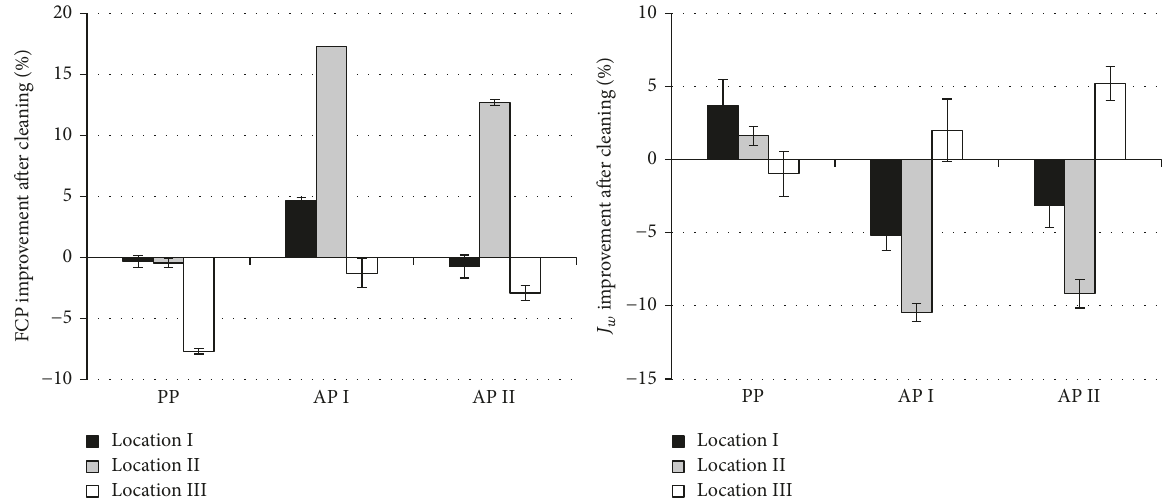
Figure 9: Normalized permeability ( 𝐾 𝑤 ) and FCP improvements after laboratory cleaning with standard plant cleaning procedure and the two adapted cleaning procedures for membrane and spacer samples from locations I, II, and III; error bars represent standard deviation (𝑛 = 2)